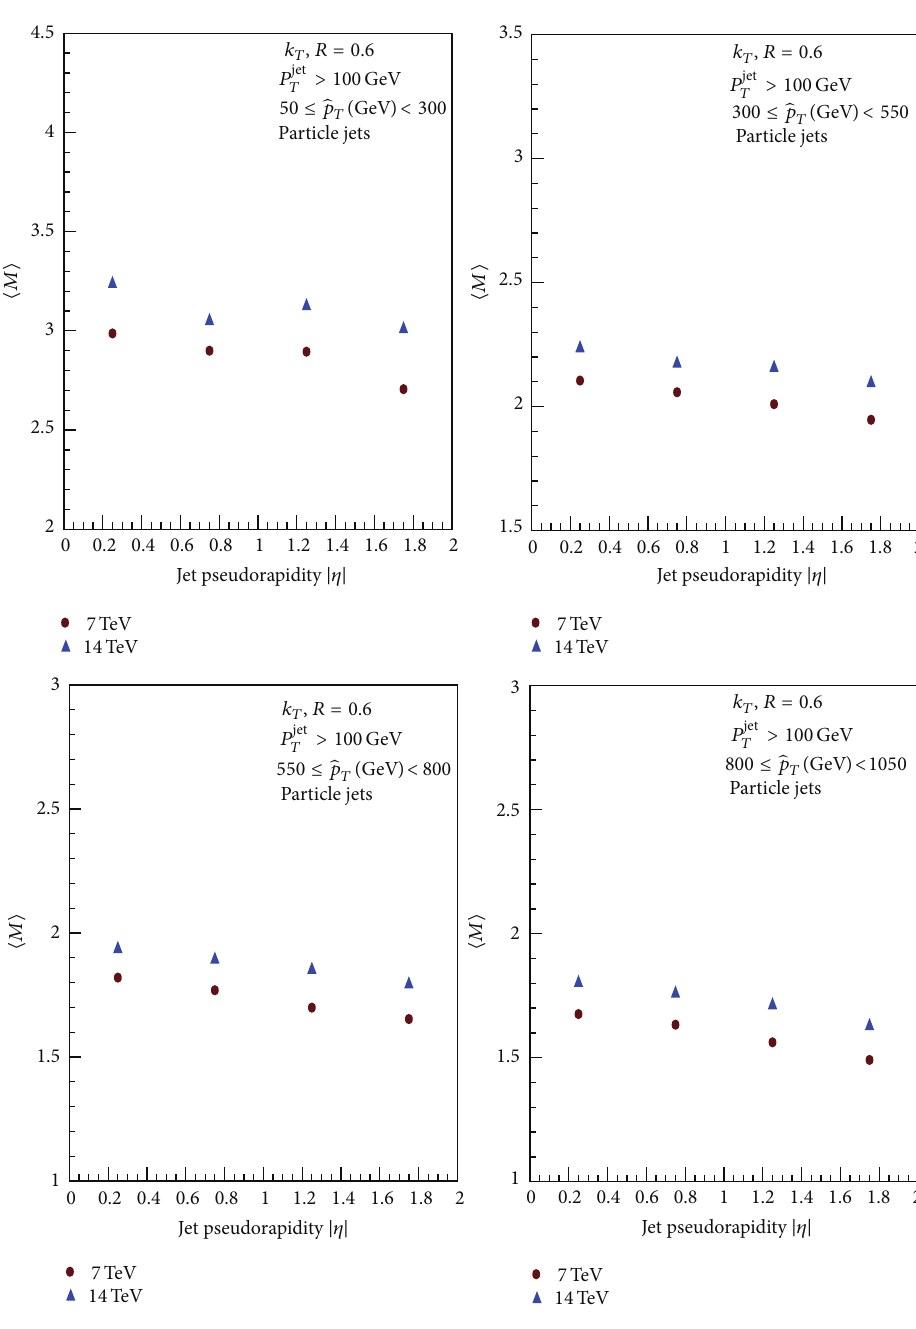
Figure7:Averagesubjetmultiplicity ⟨𝑀⟩ asafunctionofabsolutejetpseudorapidity |𝜂| inthefour ̂𝑝 𝑇 binsat √𝑠 = 7 TeVand √𝑠 = 14 TeV for 𝑘 𝑇